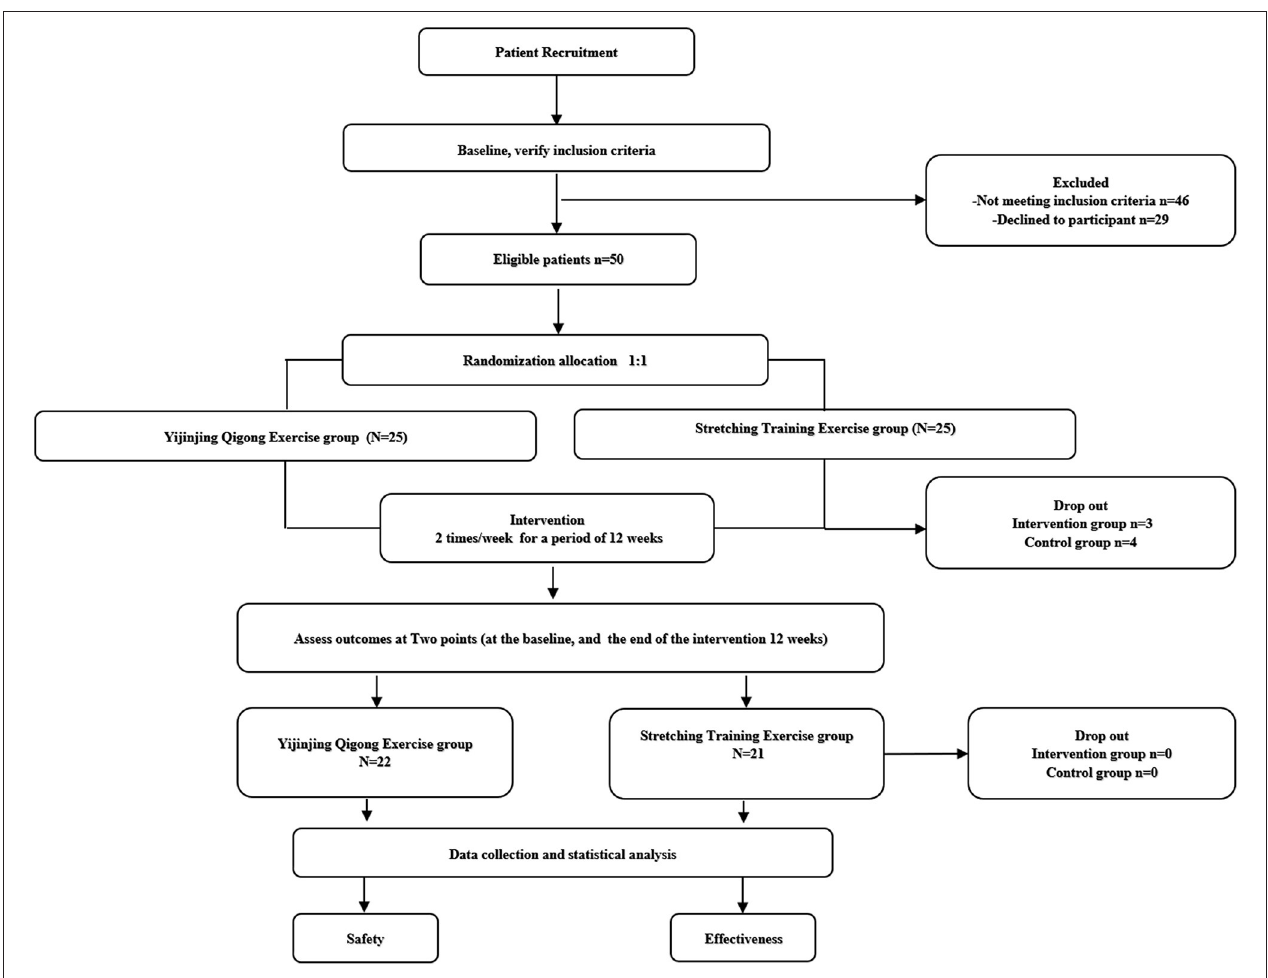
FIGURE 3 | The flow of the